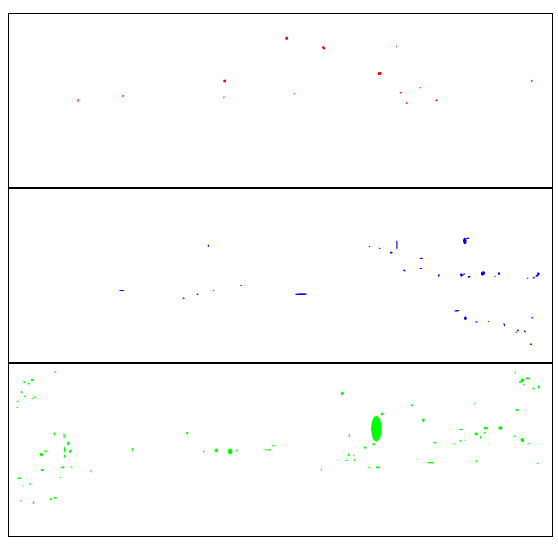
Figure 5: An ellipse is fitted to the boundaries of the connected red, yellow, and green pixels. The objects with large residuals of the ellipse fitting are not ellipse-shape objects and should be removed.